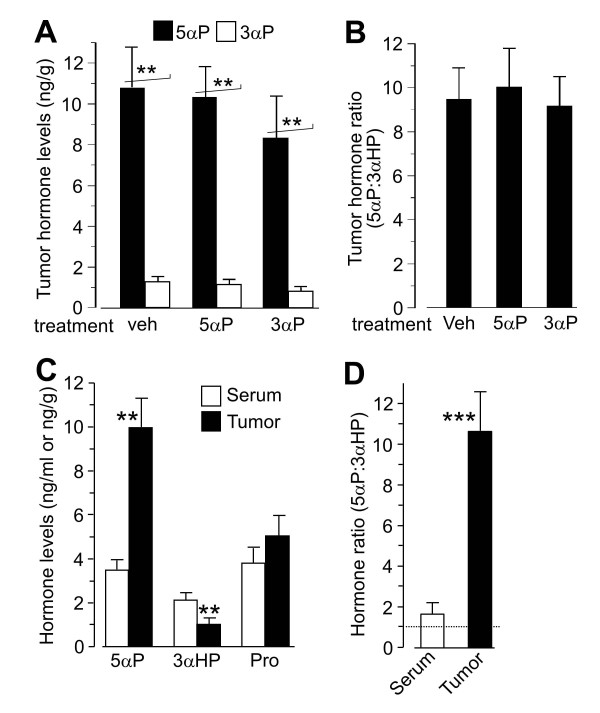
Hormone levels in tumors. (A) Effect of hormone treatment on 5αP and 3αHP levels in tumors. Hormone levels in tumors from four vehicle-injected, five 5αP-treated, and four 3αHP-treated mice were determined with RIA, as described in Methods. Hormone levels are presented as nanograms per milliliter 5αP and 3αHP and (B) as the ratio of 5αP to 3αHP. (**P < 0.01 for the comparison between 5αP and 3αHP levels). (C) Levels of 5αP, 3αHP, and progesterone (Pro) in tumors and respective sera from nine mice were determined after extraction with organic solvents and separation by thin-layer chromatography (TLC) as described in Methods. Levels of hormones are presented as nanograms per milliliter (serum) and nanograms per milligram (tumors), and (D), as the ratio of 5αP to 3αHP. **, ***Significantly different from serum levels at P < 0.01 and P < 0.001, respectively.